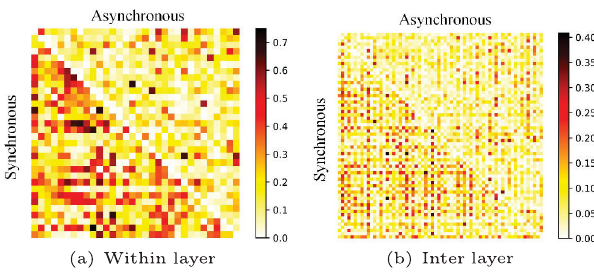
Fig. 3 Filter correlation using sync and async . (a) Correlation of 32 filters within a single layer. (b) Correlation of 64 filters between two layers inside a residual block. Upper and lower triangles respectively represent the results of sync and async weight updating training